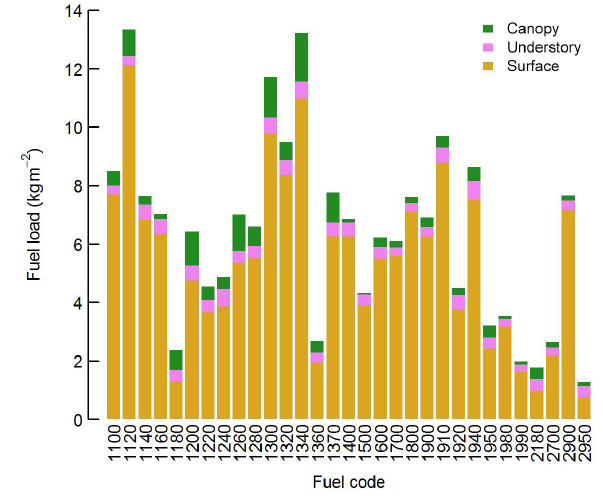
Figure 5. Best-estimate (Table 4) forest fuel loading in canopy, un- derstory, and surface fuels by fuel type.